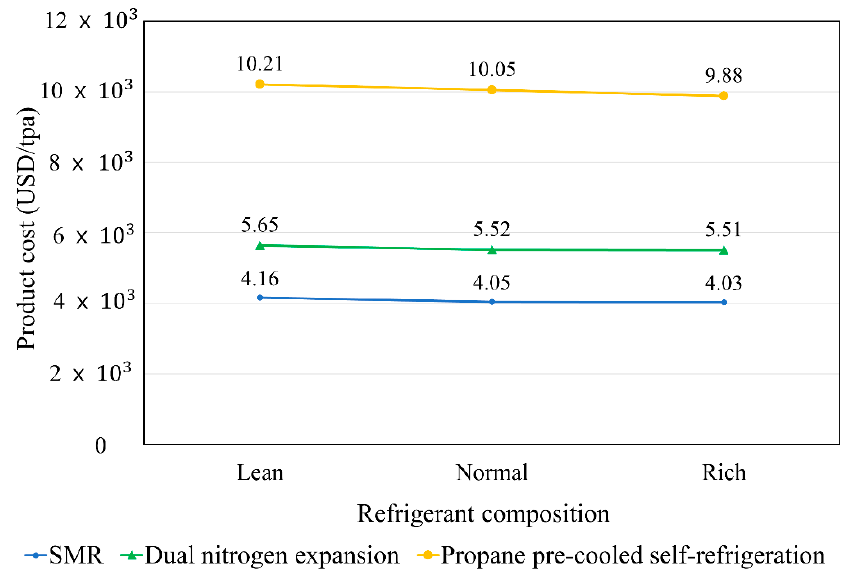
Figure 11. Effect of the natural gas compositions on the product cost of each process.